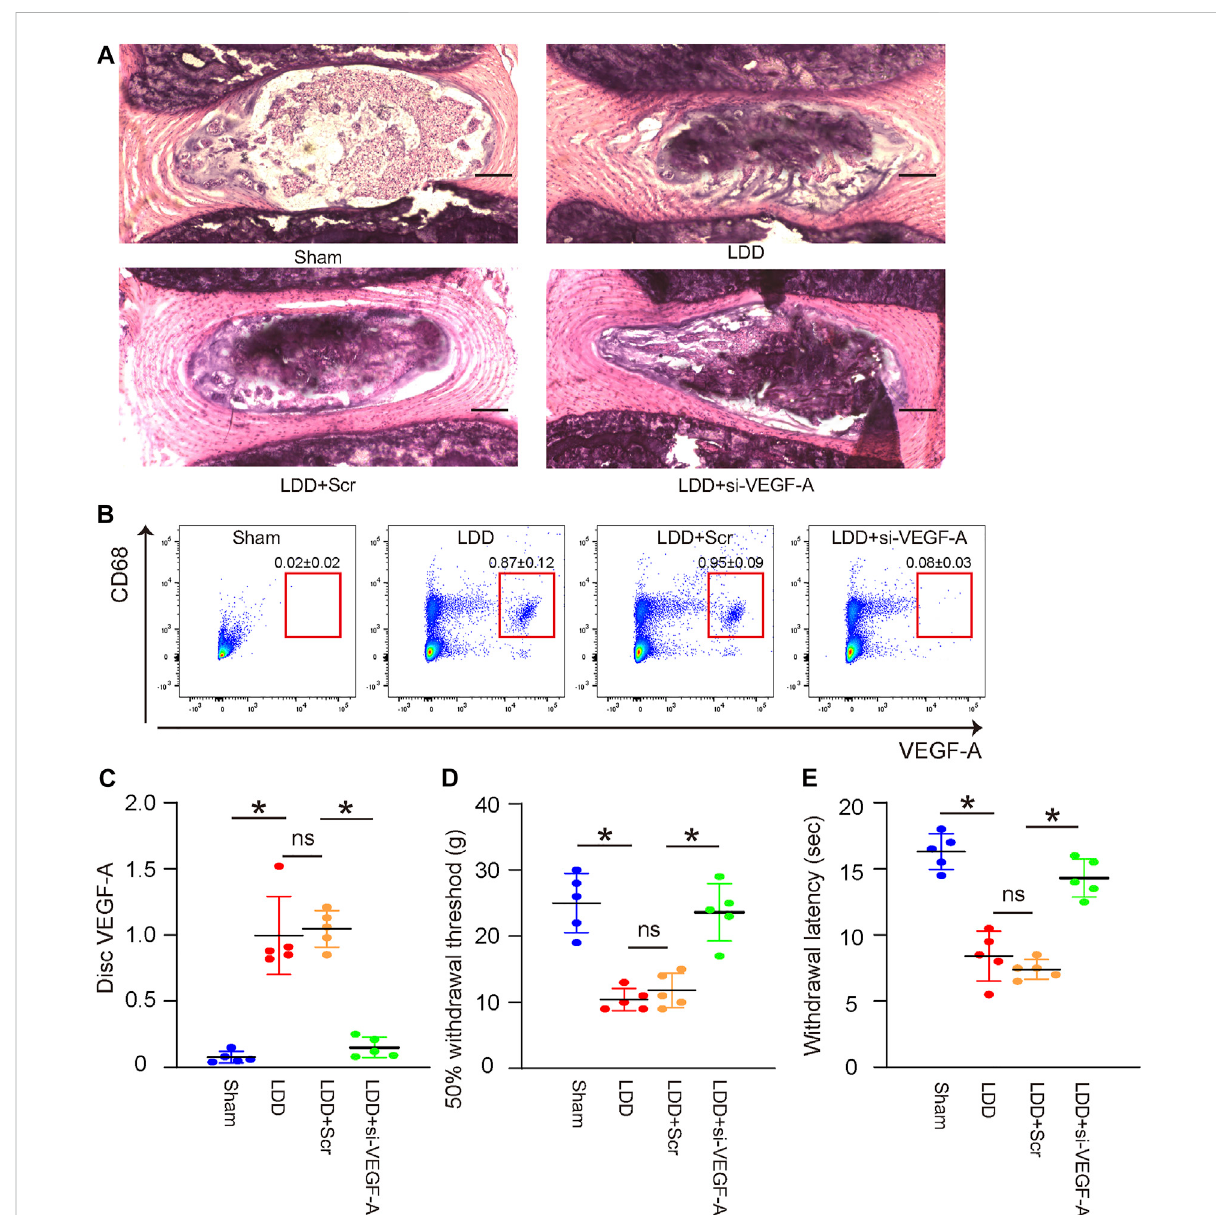
FIGURE 6 VEGF-A suppression in macrophages reduces LDD-associated pain in vivo . The effects of VEGF-A suppression in macrophages on LDD- associated pain were examined in a mouse model for LDD in vivo . Four groups of mice were included in this experiment. Group 1, mice received sham operation (Sham); Group 2, mice received LDD induction; Group 3, mice received LDD induction and simultaneous orthotopic injection of scramble-AAVs; Group 4, mice received LDD induction and simultaneous orthotopic injection of si-VEGF-A- AAVs. Mice were analyzed 4 weeks after treatments. (A) Representative H&E staining images. (B) CD68 and VEGF-A expression of disc macrophages were analyzed by FACS. (C) RT-qPCR for disc VEGF-A. (D – E) A Von Frey fi lament test for pain evaluation, shown by mechanically induced withdrawal threshold (D) and by thermally induced withdrawal latency of the paw (E) . * p < 0.05. ns, no signi fi cance. N =